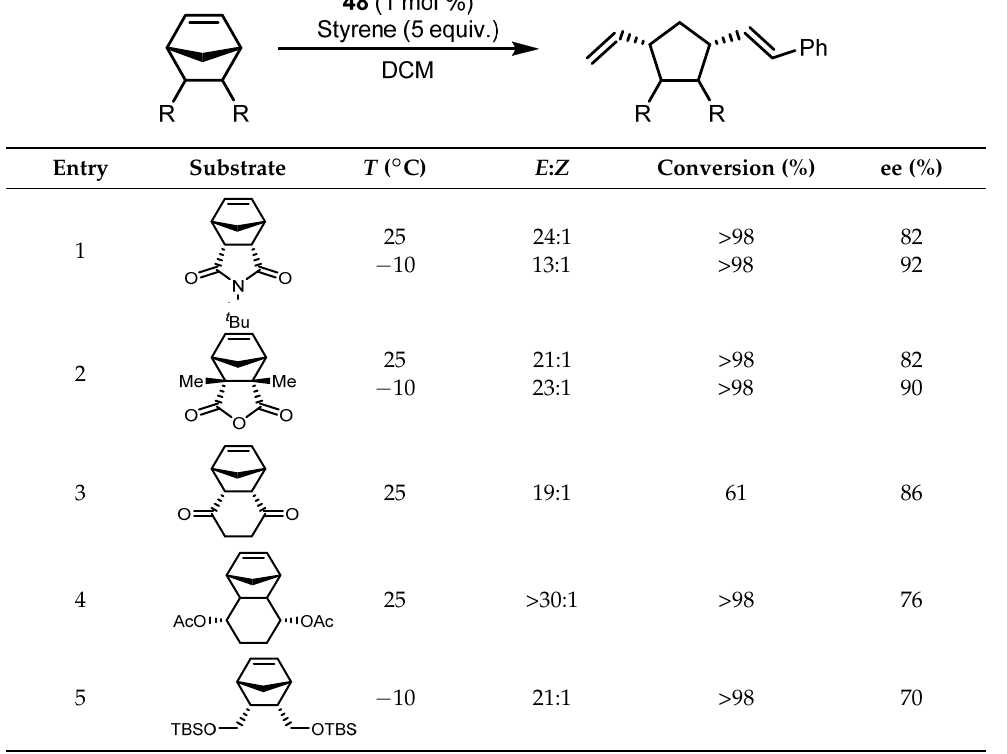
Table 16. Asymmetric ring-opening/cross metathesis (AROCM) of various substrates with styrene.